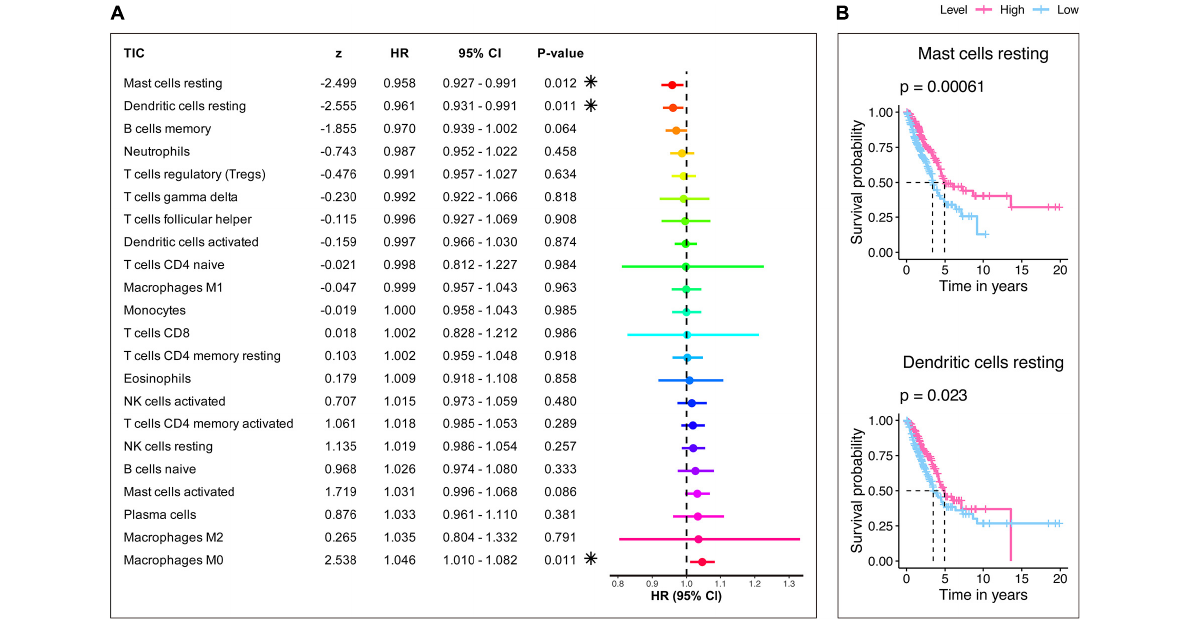
FIGURE 9 | Evaluation of the prognostic ability of 22 TICs. (A) Univariate Cox regression model built for 22 TICs based on overall survival. Asterisk shown in the B plot indicates P -value < 0.05. (B) Kaplan–Meier survival curves. Only graphs with P -value < 0.05 in the log-rank test were